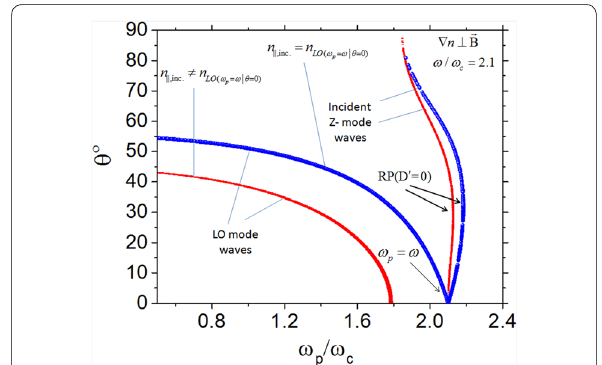
Fig. 4 Variation of wave normal angle θ as a function of ω p